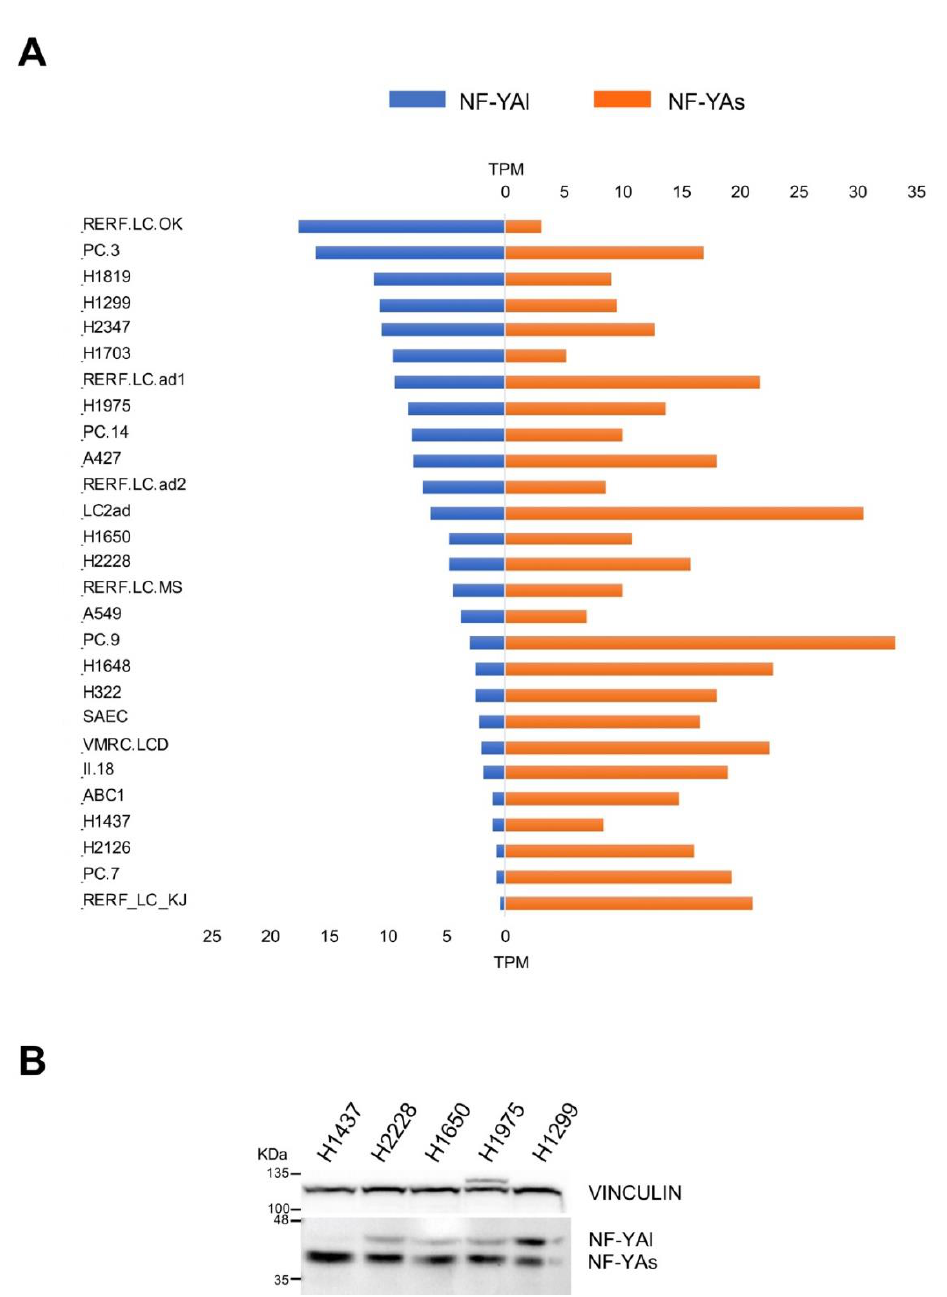
Figure 5. Expression levels of NF-YA isoforms in LUAD cell lines. ( A ) Relative levels of expression of the two NF-YA isoforms (TPMs) of the indicated LUAD cell lines as determined by RNA-Seq experiments. ( B ) Western blot analysis of NF-YA protein levels in the indicated representative LUAD cancer cell lines. Vinculin was used as an internal loading control.